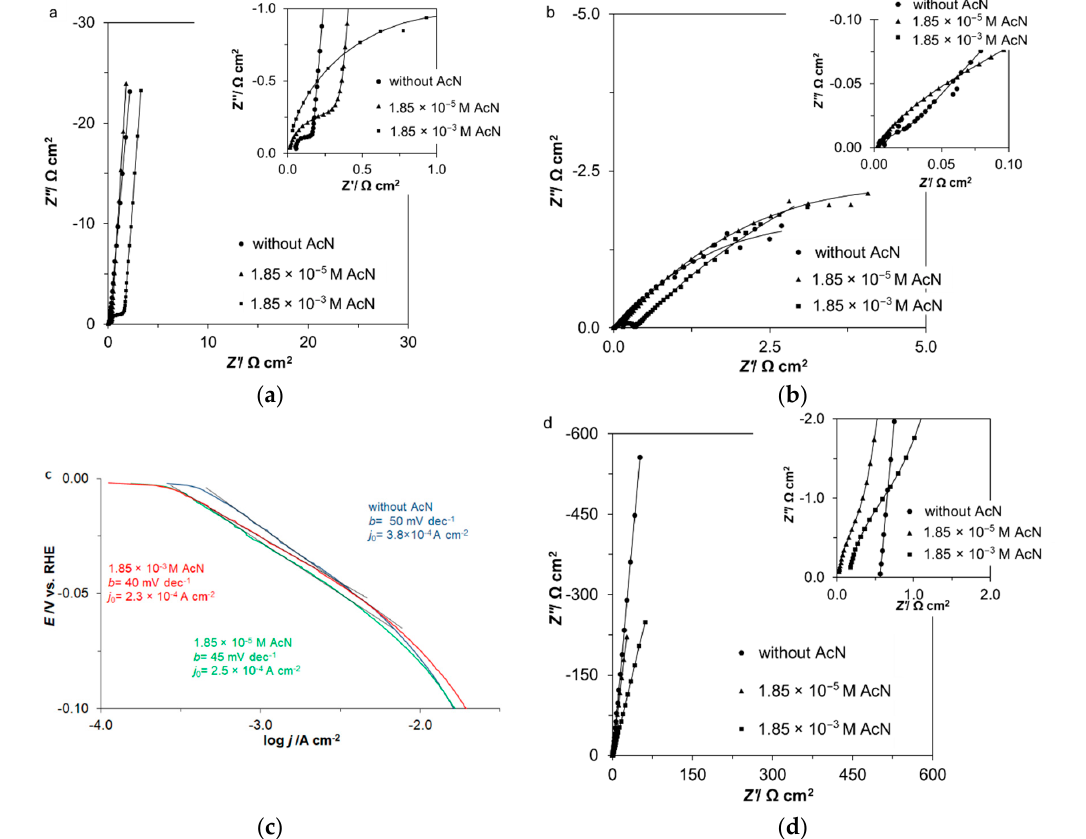
Figure 2. ( a ) Complex-plane impedance plots for the process of underpotential deposition of hydrogen (UPD of H) on polycrystalline Pt electrode in contact with 0.5 M H 2 SO 4 and in the presence of AcN for the concentrations indicated, recorded at 293 K for the potential of 100 mV vs. RHE. The solid lines correspond to representation of the data according to the equivalent circuit shown in Figure 3a and ( b ) as above, but for the process of hydrogen evolution reaction (HER), recorded at the potential of − 50 mV vs. RHE. The solid lines correspond to representation of the data according to the equivalent circuit shown in Figure 3b; ( c ) quasi-potentiostatic cathodic polarization curves (recorded at a rate of 0.5 mV·s − 1 ) under the same conditions as above; ( d ) as in ( a ) above, but recorded over the double-layer charging potential range (500 mV vs. RHE), exhibiting the AcN reversible oxidation process. The solid lines correspond to representation of the data according to the equivalent circuit shown in Figure 3c.